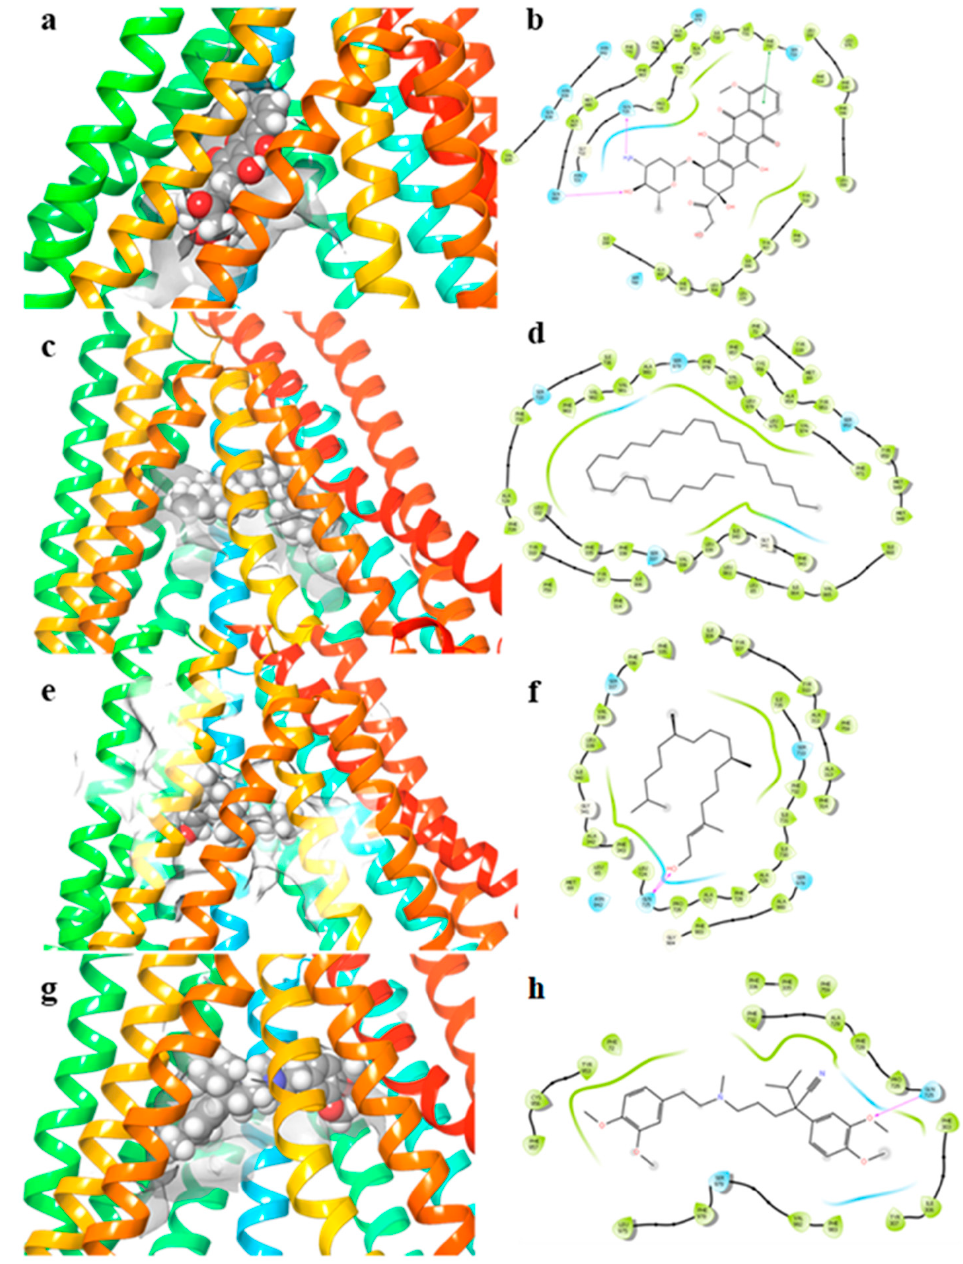
Figure 5. 3D docking poses in the DBP and 2D ligand–protein interaction diagrams. ( a , b ) doxorubicin; ( c , d ) heptacosane; ( e , f ) phytol; ( g , h ) verapamil. The purple arrows in the 2D ligand–protein interaction diagrams represent the H-bond interaction. The green line in the 2D ligand–protein interaction diagrams represent the pi-stacking interactions.